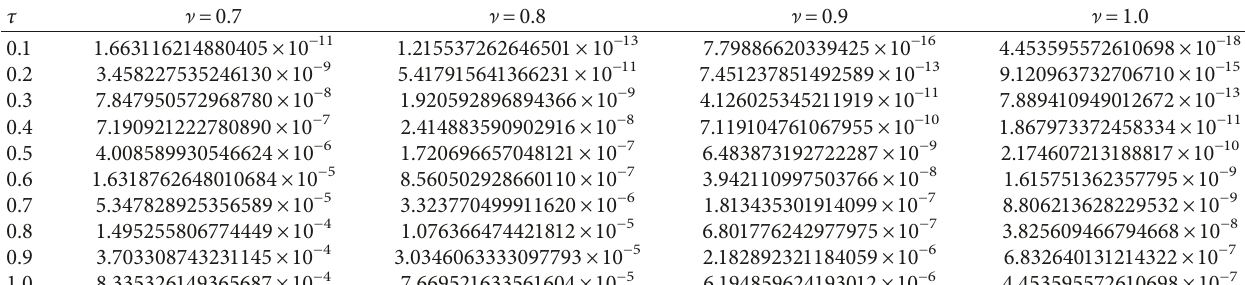
Table 12: The recurrence error of the 5th approximate solution of the imaginary part in Example 4.